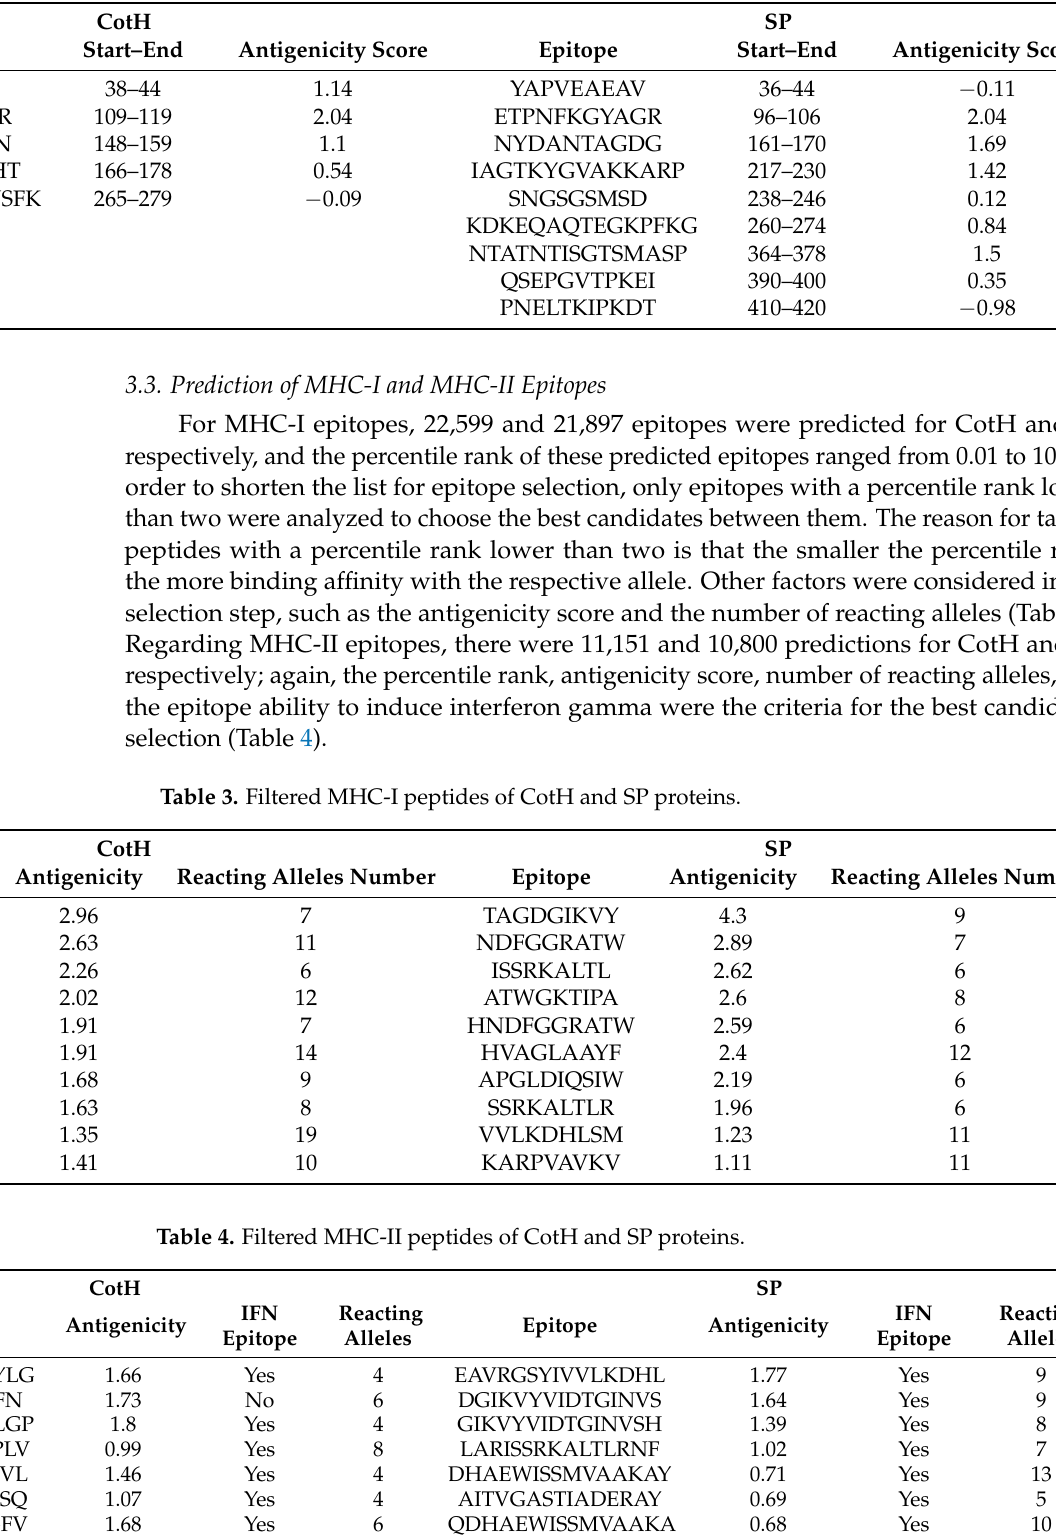
Table 2. Predicted B cell epitopes from CotH and SP proteins.